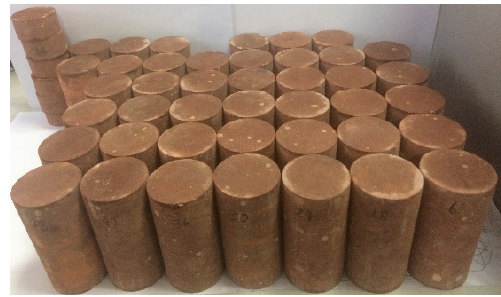
Figure 1. Standard red sandstone specimens.